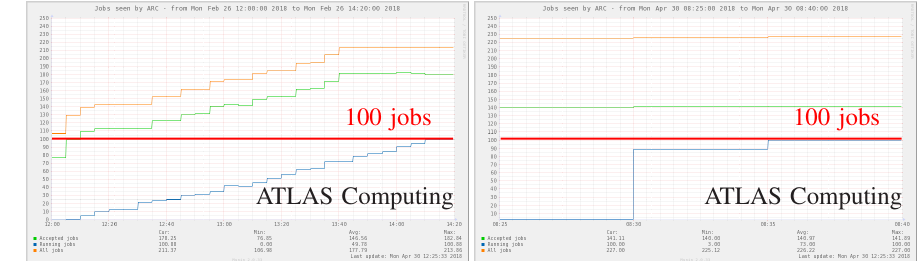
Figure 2. Time to fill 100 slots without cache (left) and with cache (right). Each bin is 5 min. The blue line represents number of running jobs.